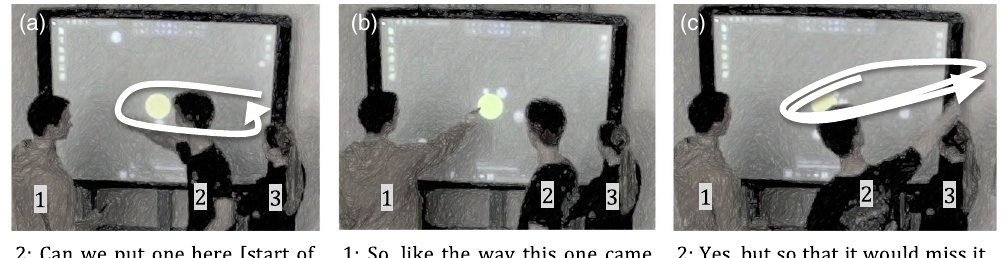
FIG. 4. Student 2 suggests that if a planet started out far away from the Sun and moved towards it, but just missed it (a),(b), it would have a very elongated orbit